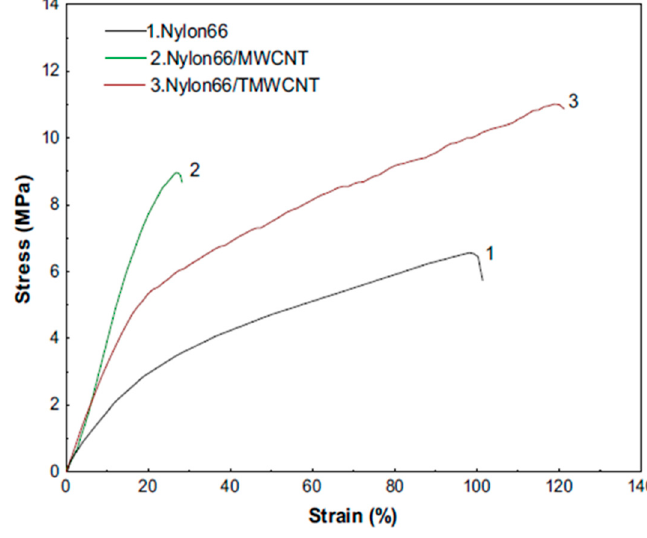
Figure 14. Strain–stress curves of PA66, PA66/ MWCNT and PA66/ TMWCNT NFs. Reprinted with permission from Ref. [118]. Copyright © 2013 Elsevier Ltd. and Techna Group S.r.l.